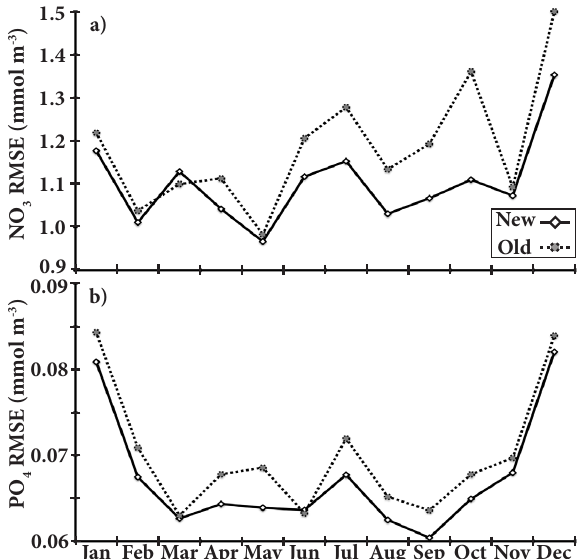
Fig. 13. Root mean squared error (RMSE) comparisons between the new and old models and WOA09 monthly (a) nitrate and (b) phos- phate data. Zonal statistics were calculated only for grid cells where observations were present and then averaged longitudinally to give a global value.